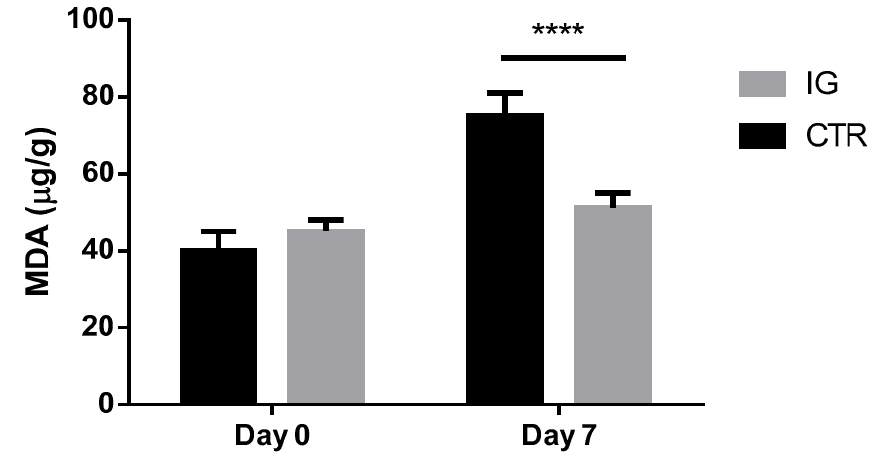
Figure 6. Malondialdehyde (MDA) levels at 0 (40 ± 5 vs. 45 ± 3) and 7 (75 ± 6 vs. 51 ± 4) days from fresh cheese ricotta stored at 4 °C: Data represent mean ± SD, **** p < 0.0001, two-way ANOVA (5 samples/group).